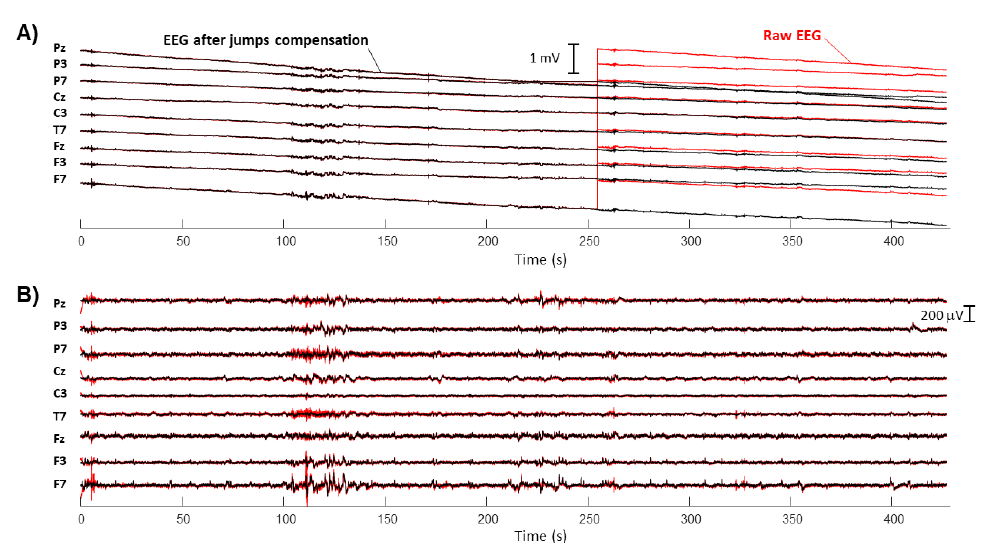
Figure 2. Example of signals (second subject during motor execution). ( A ) Raw data (red color) and EEG after compensating for jumps (black). ( B ) EEG data (with jumps compensated) after band-pass filtering (red color) and artifacts removal